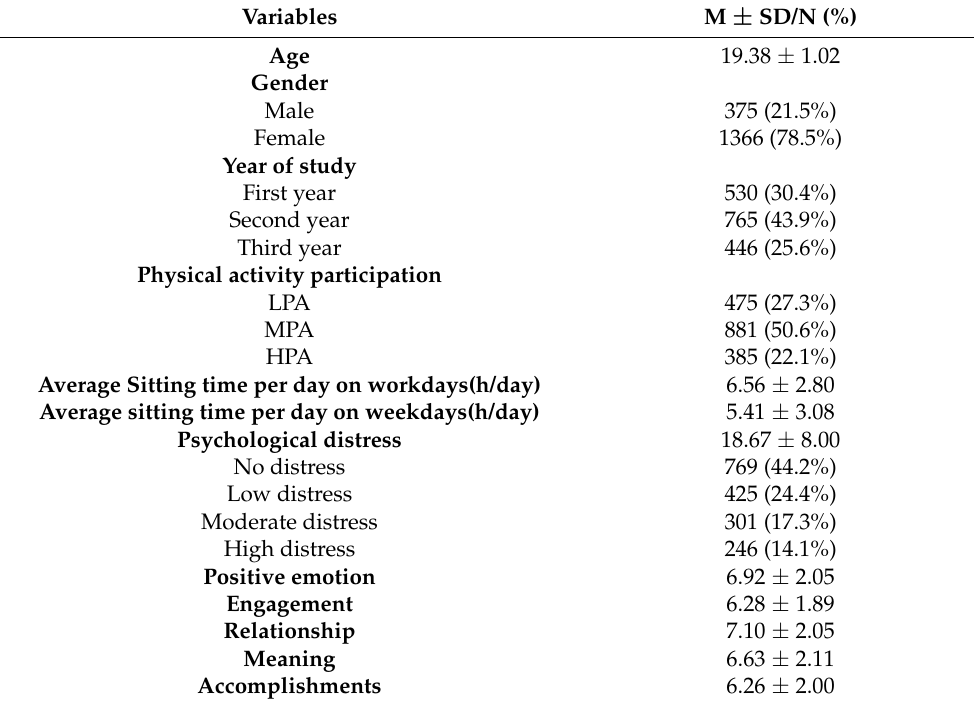
Table 1. Demographic characteristics of participants (n =